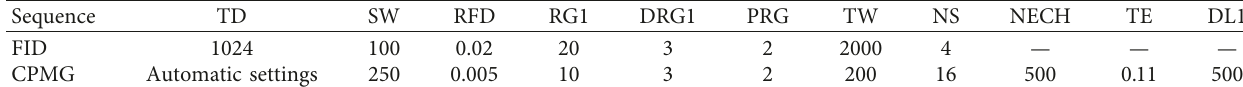
Table 3: Parameter settings for LF-NMR.